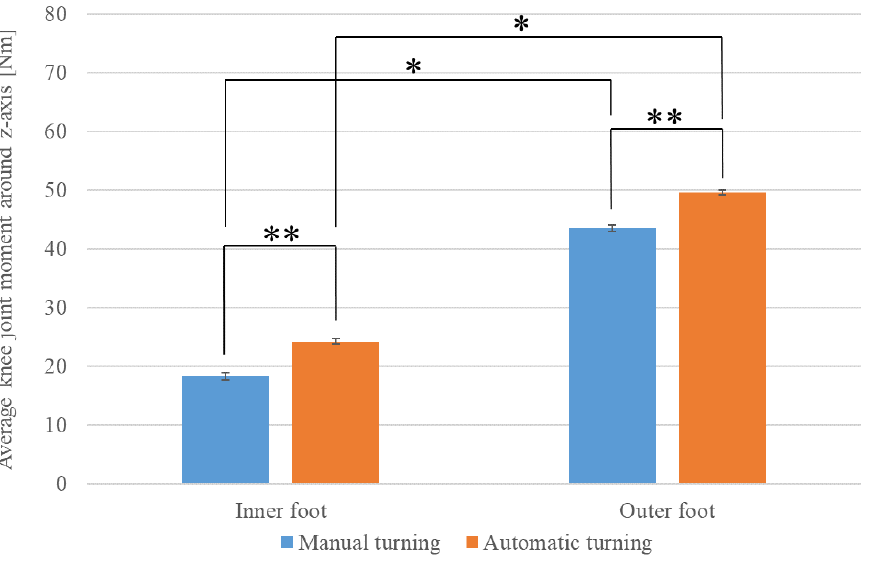
Figure 24. Average knee joint moment around z -axis during